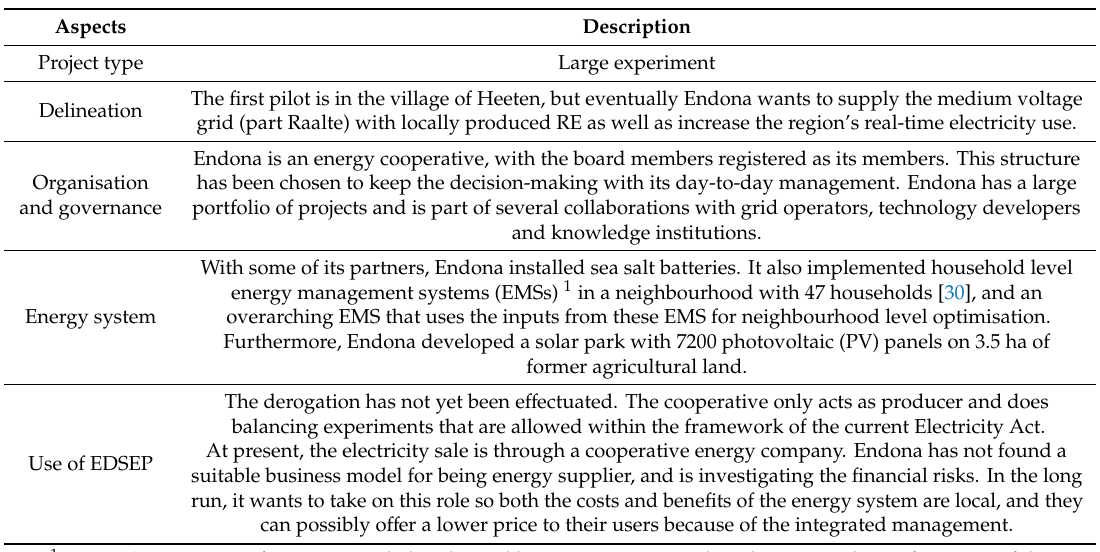
Table 3. Case study description Endona.